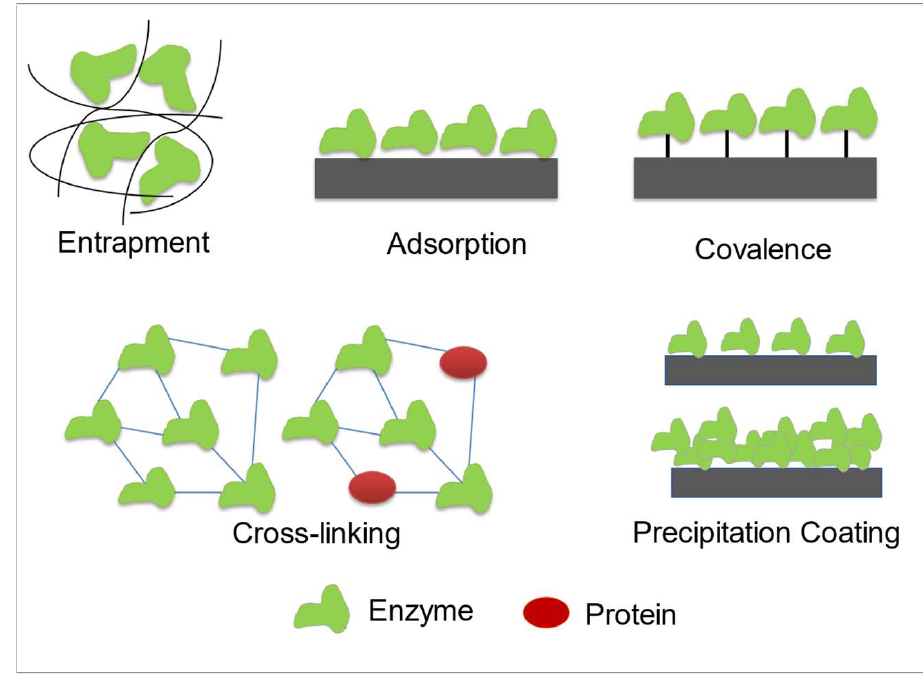
Figure 5. Schematic of the main methods for enzyme immobilization.